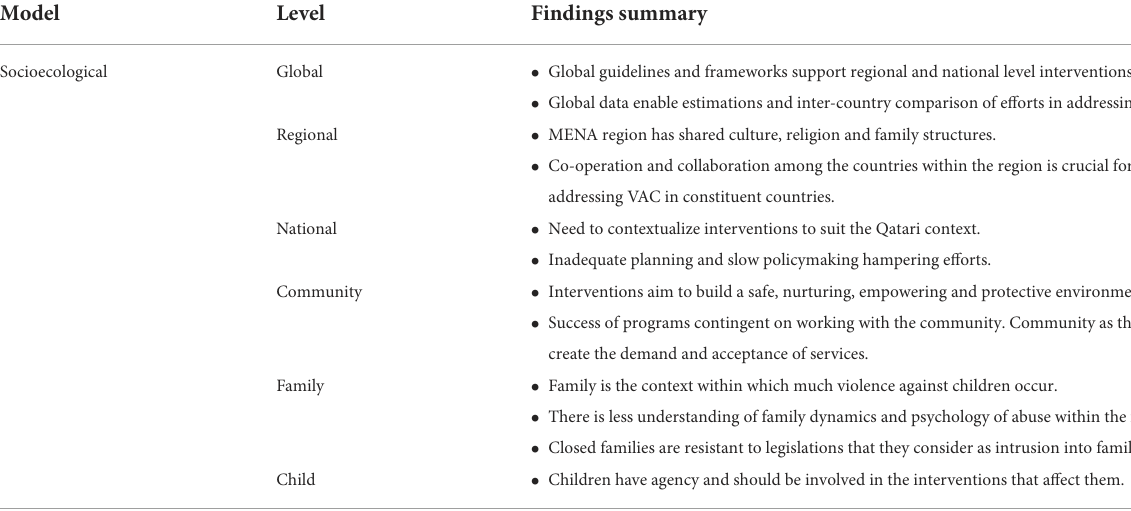
TABLE 2 Summary findings of levels of VAC interventions using adapted socioecological